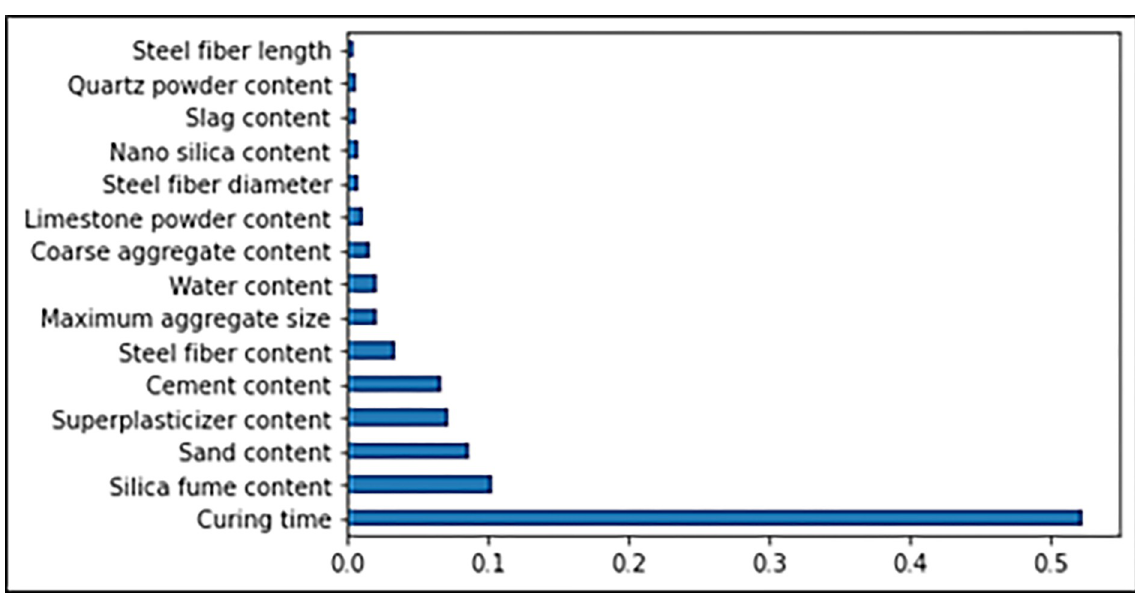
Fig 22. Feature importance of compressive strength.